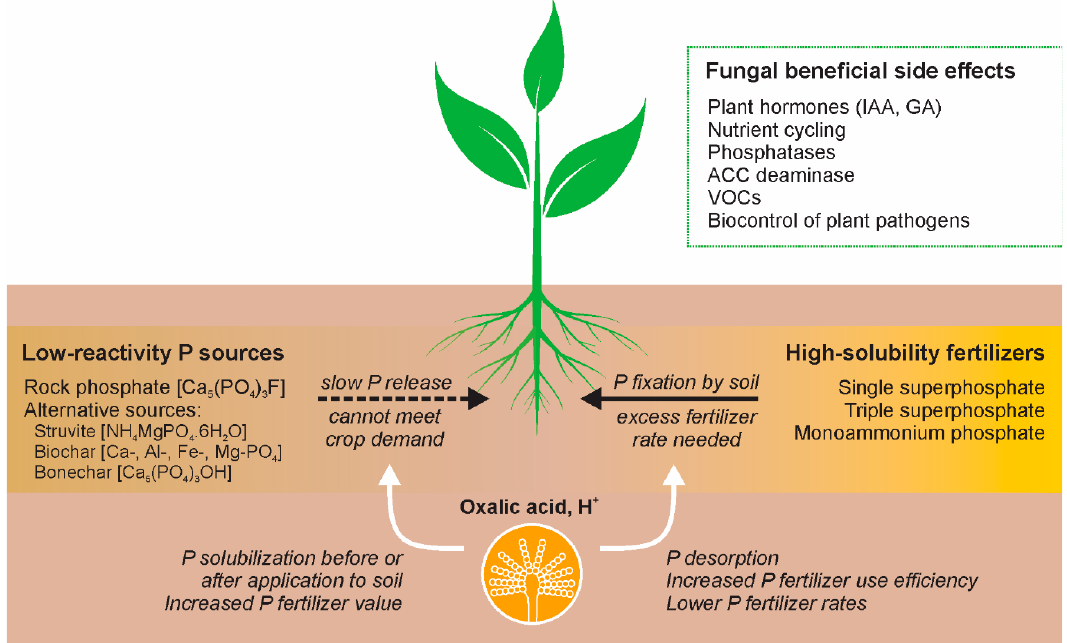
Figure 1. Fungal P-solubilization and potential beneficial side effects on plants. Fungal acidifica- tion by H + extrusion and organic acid production can improve plant access to P by the solubilization of low-reactivity P-sources and P-desorption from soil minerals. In the first case, phosphate-solubilizing fungi (PSF) can increase the fertilizer value of low-reactivity P-sources by treatment before application to the soil or by direct inoculation to the soil fertilized with the source. In the second scenario, PSF can revert P-fixation by soil, improving the fertilizer use efficiency and allowing reducing P-fertilizer rates. Moreover, PSF inoculation can promote plant growth by additional mechanisms, such as nutrient cycling, biocontrol of plant pathogens, synthesis of plant hormones such as indoleacetic acid (IAA) and gibberellins (GA), volatile organic compounds (VOCs), and enzymes. Another point is that many reports on P-solubilizing microorganisms, especially on P-solubilizing bacteria, attribute P-solubilization to gluconic acid production. Indeed,